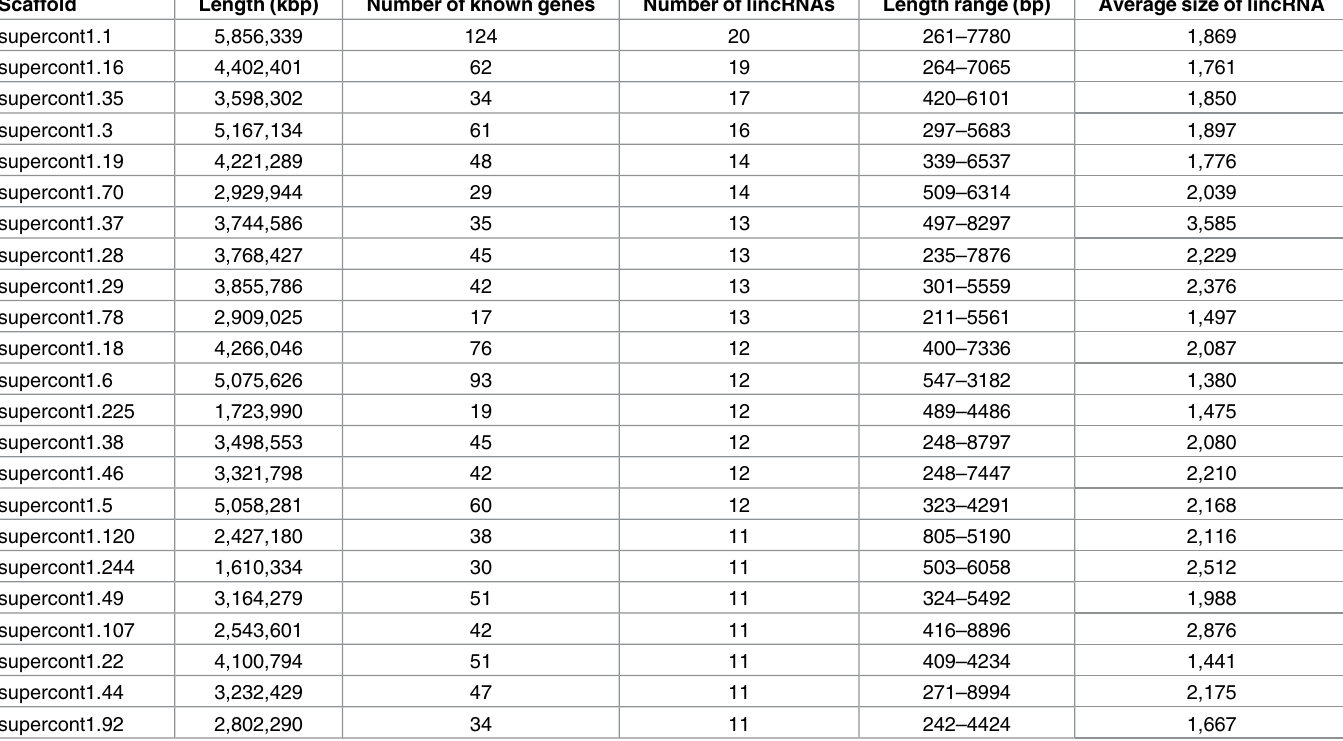
Table 1. Distribution of potential Ae . aegypti lincRNAs in different genome scaffolds with more than 10 lincRNAs and their comparison with the number of protein-coding genes.